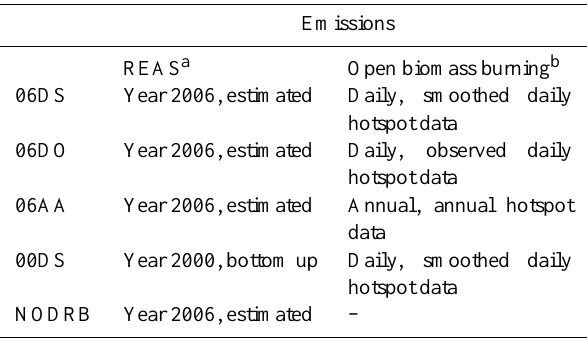
Table 1. Sensitivity model experiment